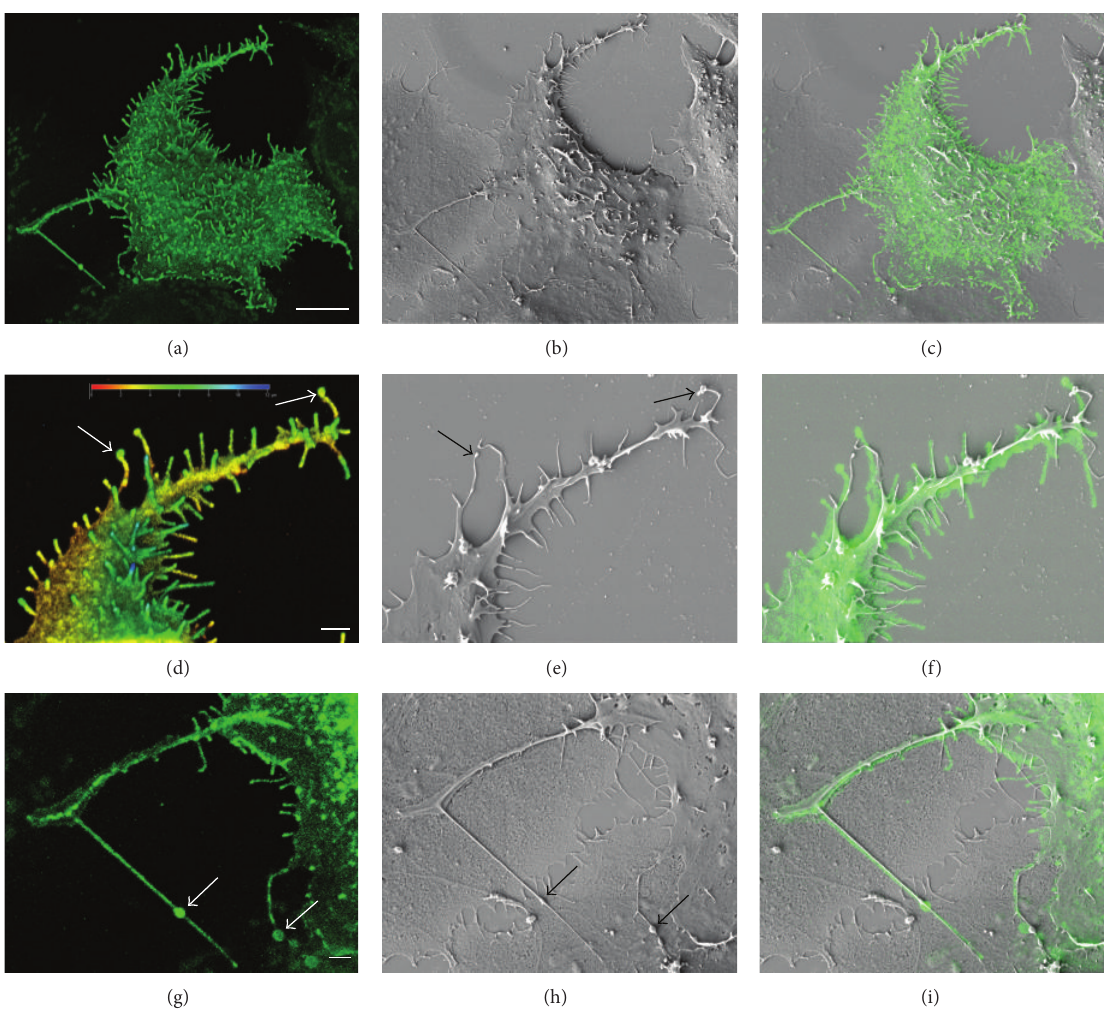
Figure 2: GFP-HAS3-induced plasma membrane protrusions imaged by CLEM. A GFP-HAS3 expressing MCF-7 cell imaged by 3D confocal microscopy in (a), (d), and (g) and by SEM in (b), (e), and (h). Merged images are presented in (c), (f), and (i). High magnification images from selected areas of the same cell presented in (a)–(c) are shown in (d)–(i). Arrows in (d), (e), (g), and (h) indicate the GFP-HAS3-positive bulbous expansions in both the body and tips of protrusions. Color depth coding was used to demonstrate the variable length of protrusions in (d). Scale bars 10 𝜇 m in (a), 2 𝜇 m in (d) and